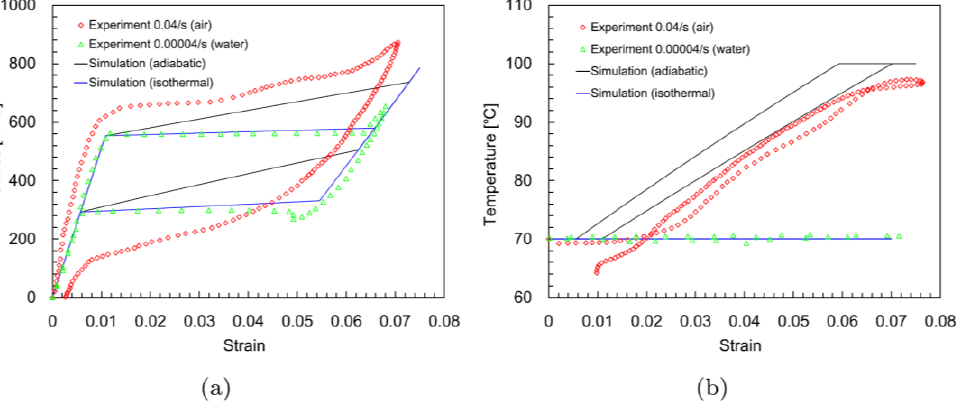
Figure 12. Comparisons between simulation results and experimental data in isothermal and adiabatic conditions: ( a ) stress-strain curves and ( b ) temperature-strain curves [95]. (Reprinted from Ref. [95], Fig. 7, 2017, with permission from Institute of Physics Publishing, Ltd.)